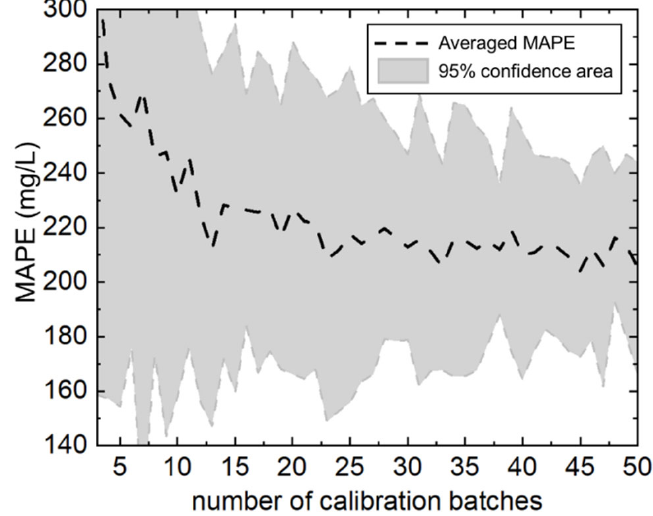
Figure 5. MPLS performance sensitivity to the available process calibration batches in the estimation of mAbs titer at harvest. Black dashed line—average validation MAPE (averaged over the 20 random selections of the calibration batches from the set of process batches) as a function of the number of calibration batches; grey area—95% confidence area of the distributions.